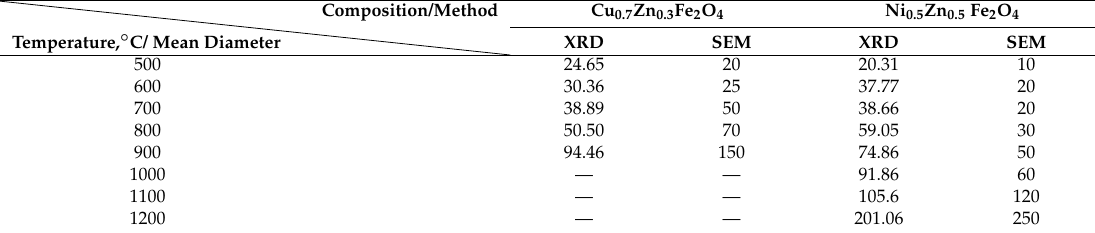
Figure 7. The surface morphologies of Ni 0.5 Zn 0.5 Fe 2 O 4 at different sintering temperatures. ( a ) Not sintered (100 KX), ( b ) 500 ◦ C (100 KX), ( c ) 600 ◦ C, ( d ) 700 ◦ C, ( e ) 800 ◦ C, ( f ) 900 ◦ C, ( g ) 1000 ◦ C, ( h ) 1100 ◦ C, ( i ) 1200 ◦ C. Table 3. The effect of sintering temperature on the mean